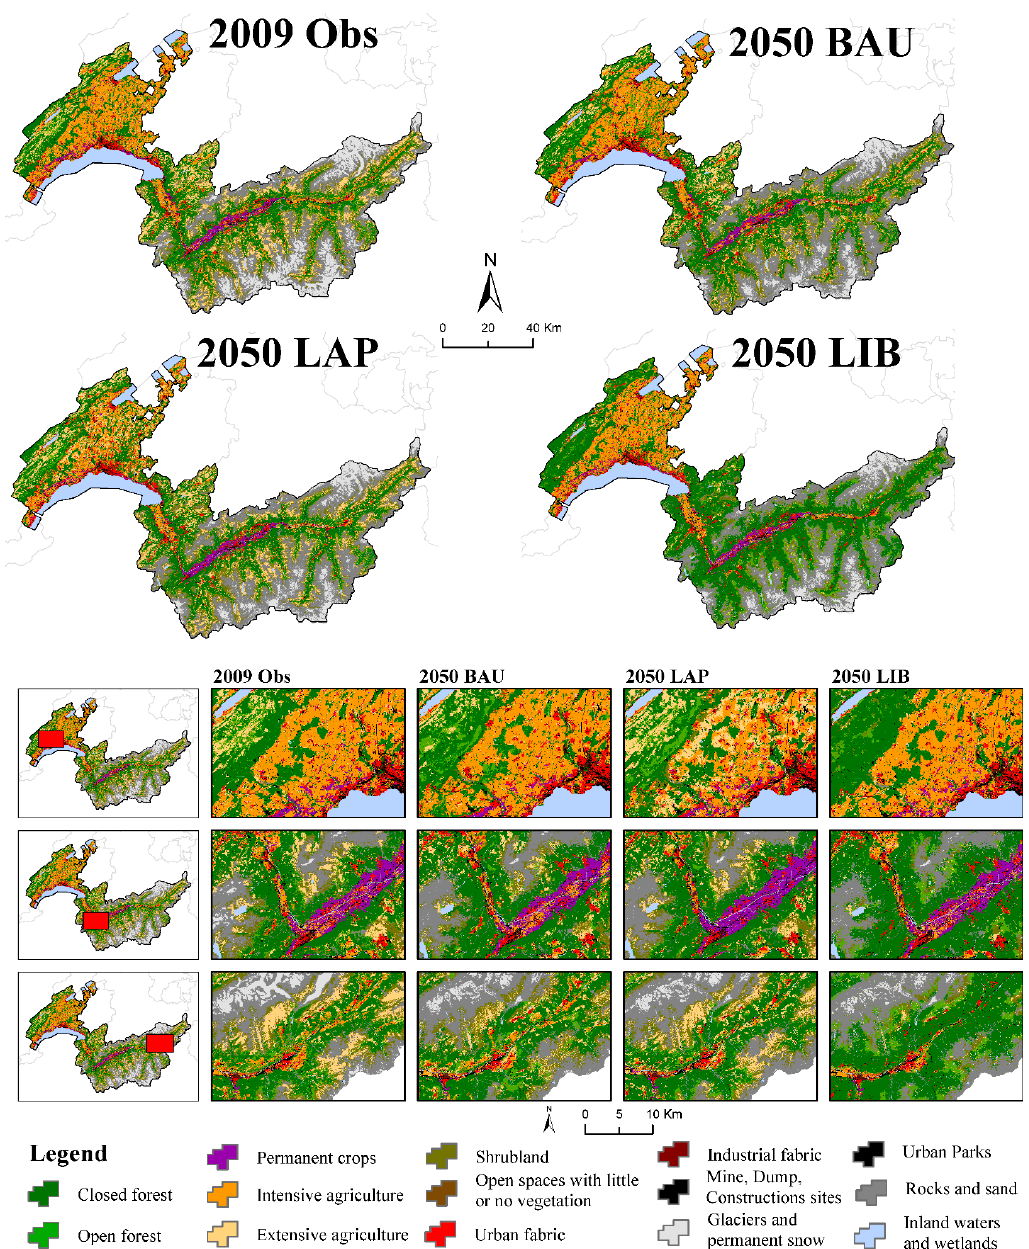
Figure 4. Observed land use in 2009 and results from Dinamica EGO model simulation showing the landscape composition for the year 2050 in each scenario (business-as-usual (BAU), LAP, and LIB).